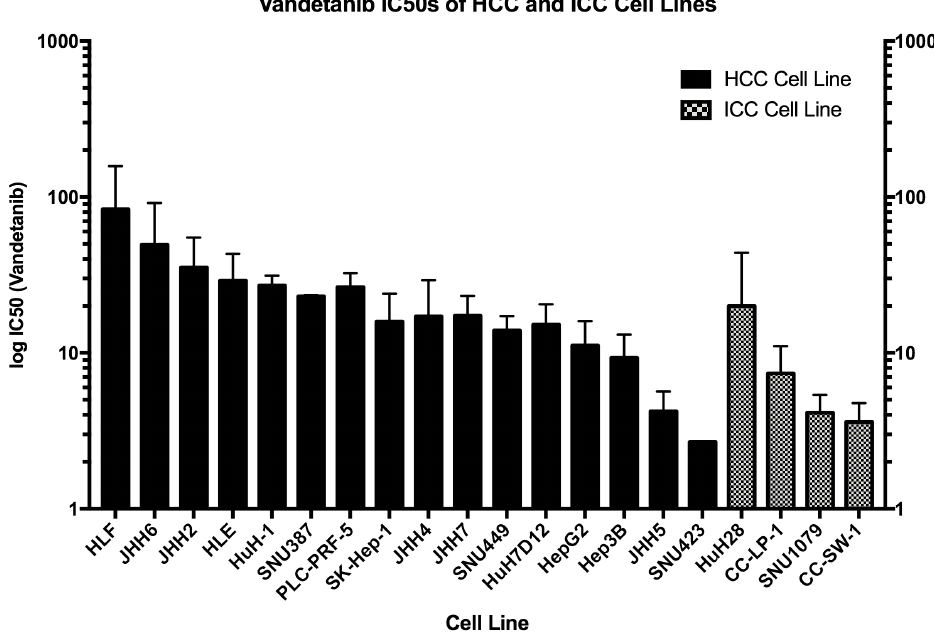
Figure 2. Vandetanib IC 50 in HCC and ICC cell lines. The IC 50 response observed in both Hepatocellular Carcinoma (HCC) and Intrahepatic Cholangiocarcinoma (ICC) cell lines demonstrated more than twenty-fold variation (range 2.7–83 µ M, IQR 5.71–24.1 (19.9), error 0.25–52.5). Cell lines were tested under conditions of short exposure to drug (24 h) and measured at five days. HCC cell lines of more invasive character (HL- and JHH- cell line families) showed the least response across all cell